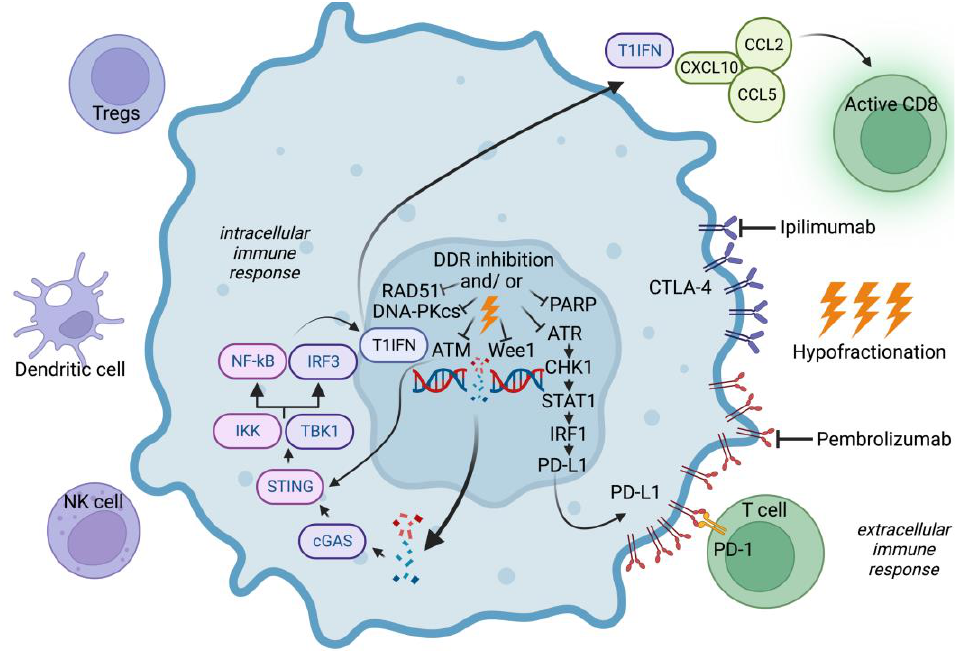
Figure 3. Interplay of DNA damage response inhibition and immune checkpoint inhibition with irradiation to intensify tumor therapy. Inhibition of DDR can lead to DNA damage accumula- tion, with both double-stranded DNA and single-stranded DNA accumulating in the cytoplasm. Cytoplasmic DNA activates the cGAS/STING pathway and thereby the type I interferon (IFN) path- way, which ultimately activates both chemokines and immune cells (such as T cells, NK cells, and DCs). Specifically, STING promotes phosphorylation and nuclear shift of type I IFN transcriptional regulatory factors TBK1 and IFN regulator 3 (IRF3), while activating the NF- κ B pathway that inter- acts with IRF3. IKK stimulates the type I IFN pathway through downstream transcription factors. Activated TIL releases IFN γ , which acts on tumor cells and mediates STAT1/3-dependent PD-L1 upregulation. The ATM/ATR/Chk1 pathway can also trigger PD-L1 expression. ATM can directly activate and participate in STING-mediated pathways, and PARPi can promote PD-L1 expression by downregulating GSK3 β . The NF- κ B pathway can be activated to promote transcription and secretion of various pro-inflammatory factors. Following this sequence of events, these factors serve to promote DC activation and elicit an immune response. Radiation sensitization can be achieved by hypofractionated irradiation in combination with the immune checkpoint inhibitors ipilimumab or pembrolizumab. (ATM: ataxia telangiectasia mutated protein; ATR: ataxia telangiectasia and Rad3-related protein; CCL2 or 5: C-C motif chemokine ligand 2/5; cGAMP: cyclic GMP-AMP; cGAS: cyclic GMP-AMP synthase; CHK1: Checkpoint kinase 1; CXCL10: C-X-C motif chemokine ligand 10; CTLA-4: cytotoxic T-lymphocyte-associated protein 4; DDR: DNA damage response; DNA-PKcs: DC: dendritic cell; DNA protein kinase catalytic subunit; IKK: I κ B kinase; IRF1: Interferon regulatory factor 1; IRF3: interferon regulatory factor 3; NF- κ B: nuclear factor kappa-B; natural killer cell; PARP: poly-ADP-ribose polymerase; PD-1: programmed cell death protein 1; PD-L1: programmed death ligand 1; RAD51: recombinase RAD51; STAT1/3: Signal Transducer and Activator of Transcription 1/3; STING: Stimulator of Interferon Gene; T1IFN: Type I Interferon; TBK1: TANK binding kinase-1; Regulatory T cells; Wee1: Wee1 G2 checkpoint kinase). Created with BioRender.com.